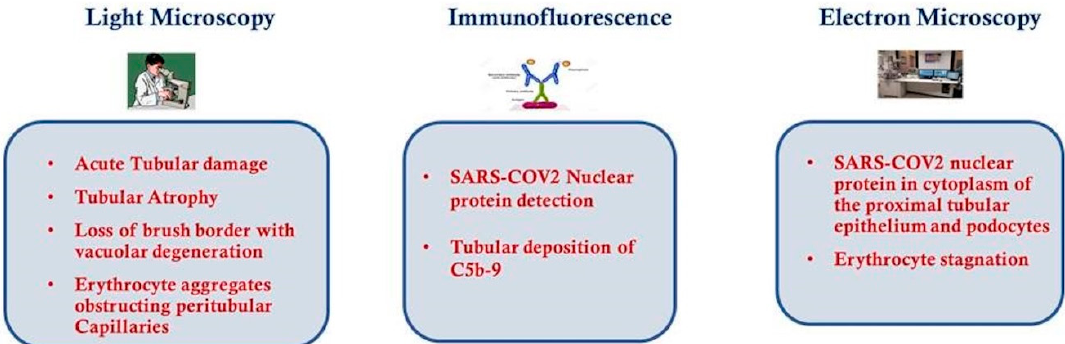
Figure 2. Histological features of kidney from COVID-19 patients.